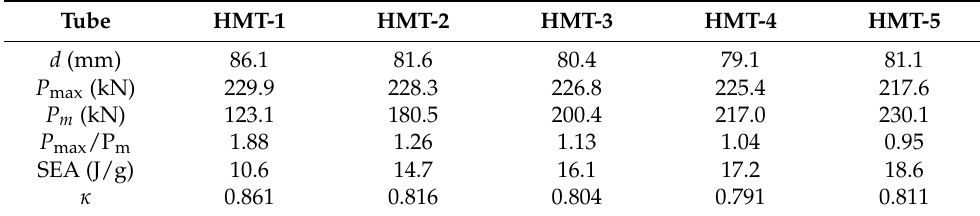
Table 7. FEM-simulated crushing data of HMTs based on tangent method.